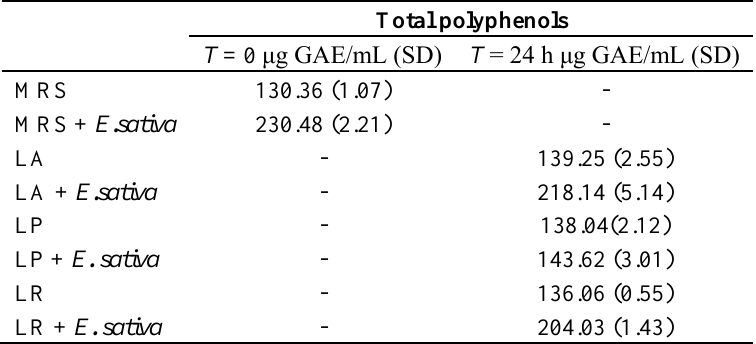
Table 2. Total polyphenols present in MRS medium with and without E. sativa , before and after 24 h of growth of L. acidophilus (LA), L. plantarum (LP) and L. rhamnosus (LR). The data are expressed as µg gallic acid equivalent (GAE)/mL and represent the mean (±standard deviation) of three independent experiments.